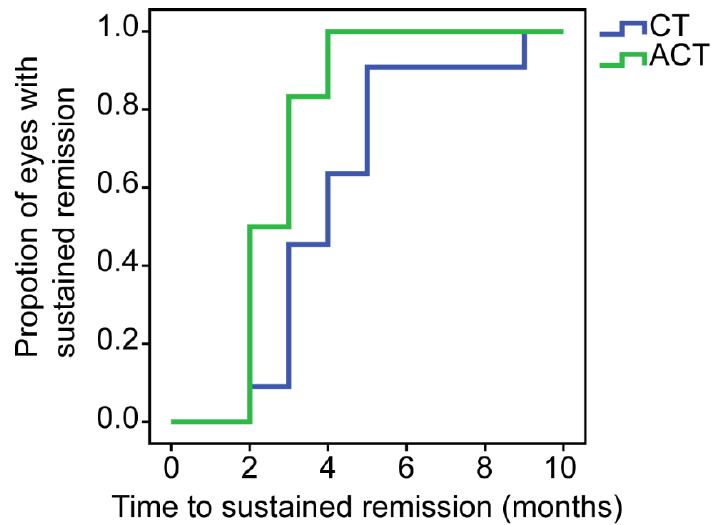
Figure 1. Kaplan–Meier curve of time to sustained remission of scleritis since baseline. In the 4th month, 100% of the ACT (adalimumab plus conventional therapy) group achieved sustained remission, and in the 9th month, 100% of the CT (conventional therapy) group achieved that. Scleritis flares (defined as an increase in McCluskey’s scores ≥ 2) occurred in 11/11 eyes in the CT group and 5/12 eyes in the ACT group during follow-up ( p = 0.005). The median time to first flare was 4 months (in the CT group) and 11.5 months (in the ACT group) from baseline ( p = 0.019). The Kaplan–Meier curve shows a longer duration of no-flare-survival in the ACT group (Figure 2). Notably, 7/12 eyes in the ACT group had no flare throughout the follow-up period. Two eyes in the CT group experienced flares more than once. After calculation, the median number of flares per eye per month was 0.125 in the CT group and 0 in the ACT group. The median number of relapses per eye in the CT group was 1 (1, 1), and that in the ACT group was significantly lower (0, [0, 1], p = 0.006). The starting dosages of oral GCs were similar in the two groups (30 ± 5.449 mg in the CT group vs. 31.67 ± 24.206 mg in the ACT group, p = 0.845), as the patients were all in the active period at baseline. The dosage was adjusted according to the disease activity during the following visits. Changes in GC dosage during follow-up are presented in Figure 3. Until the seventh month, the average GC dosage was reduced to less than 10 mg/day in both groups, which realized successful GC sparing as defined by the Standardization of Uveitis Nomenclature (SUN) Working Group [27]. However, the ACT group achieved a faster reduction in GC